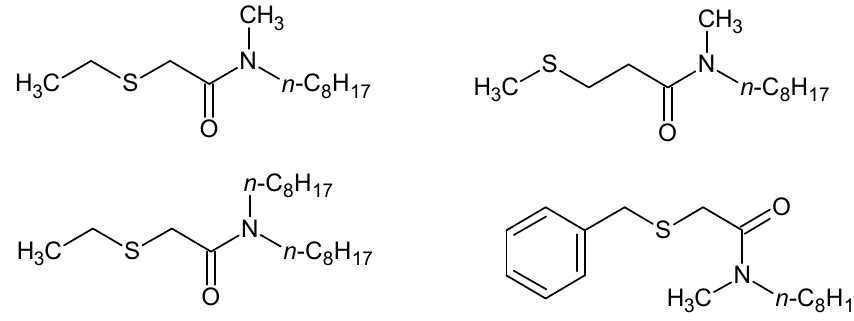
Figure 3. The structures of the Pd(II) extractants investigated by Narita et al. [35].